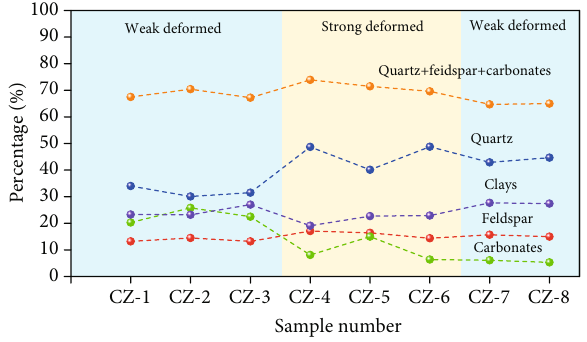
Figure 8: Mineral composition of the Lujiaping shale.